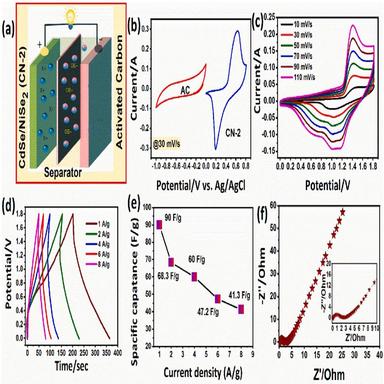
(a) Schematic of the CN-2//AC hybrid supercapacitor, (b) voltammogram of AC and CN-2 electrodes at different potentials, (c, d) CV, and discharge/charge features of the CN-2//AC hybrid supercapacitor, (e) capacitance against current rate plot, (f) impedance plot, (inset) indicate the zoomed view.